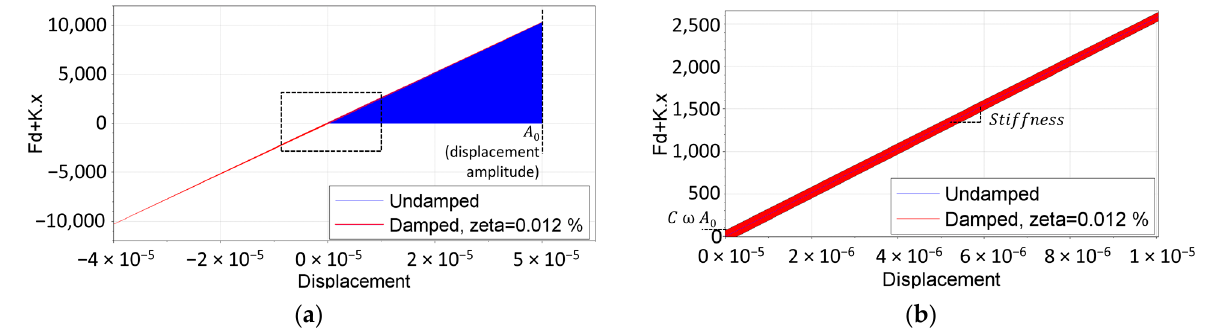
Figure 3. Undamped and damped displacements and energies: ( a ) Elastic energy and hysteretic cycle; ( b ) Zoomed in of damping loop (dissipated energy).